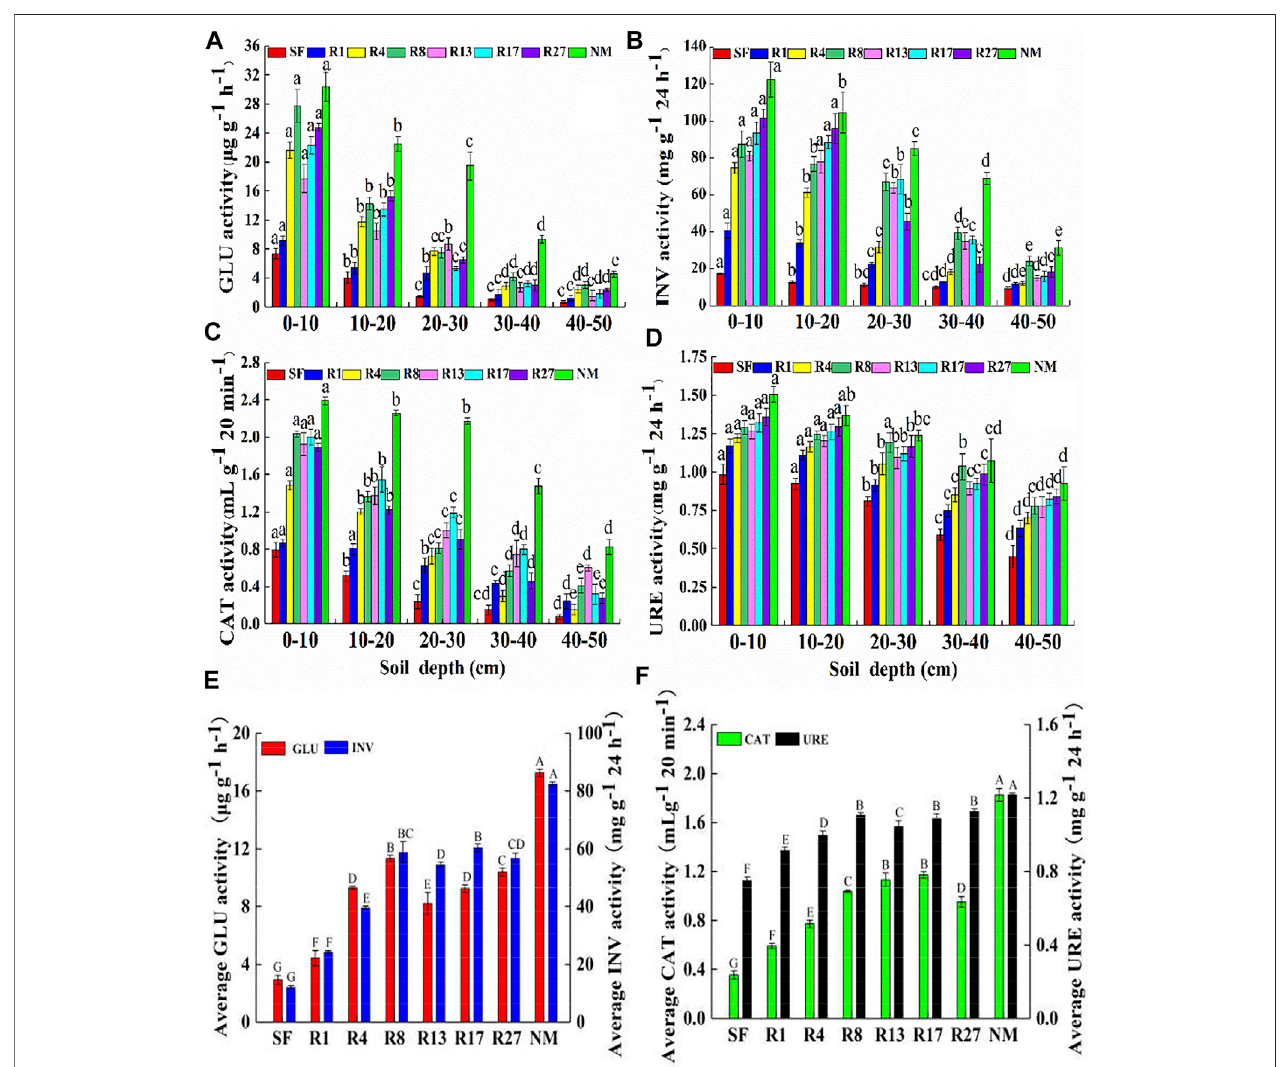
FIGURE 3 | Distribution of soil enzyme activity at the soil 0 – 50 cm depth (A – D) and average soil enzyme activity of different sites (E – F) . GLU, β -glucosidase; INV, invertase; CAT, catalase; URE, urease. SF, soybean fi eld; R1, R4, R8, R13, R17, and R27, restored sites after 1, 4, 8, 13, 17, and 27 years of farmland abandonment; NM, natural marsh. Different lowercase letters in (A – D) indicate signi fi cant differences between different layers in the same site ( p < 0.05). Different uppercase letters in (E – F) indicate signi fi cant differences of the average value of the fi ve layers between different sites ( p < 0.05).